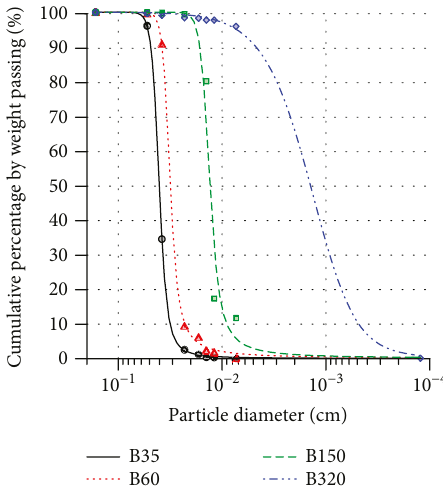
Figure 2: Grain size distribution curves of sands B35, B60, B150, and